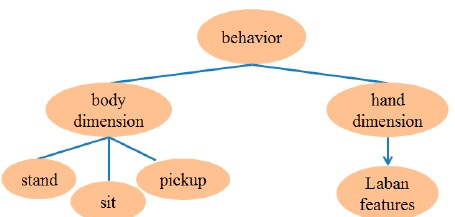
Figure 9. Illustration of algorithms for behaviors in cognitive map.